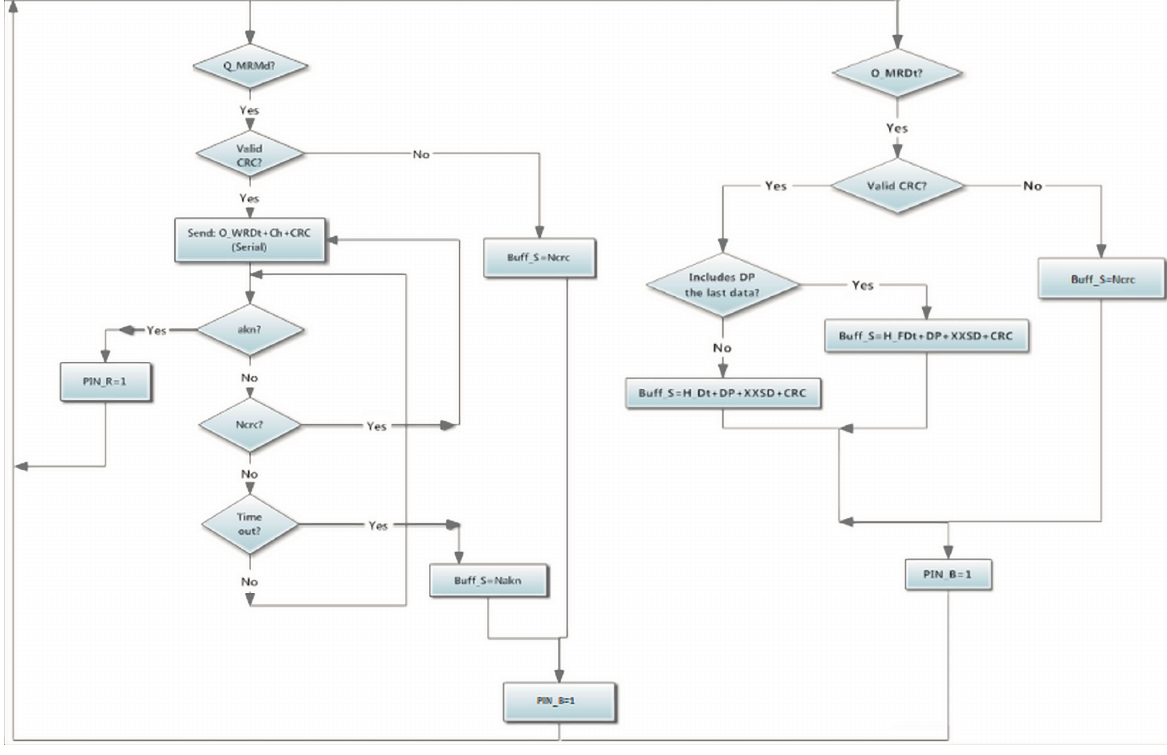
Figure 7. Flowchart of wireless orders from Master